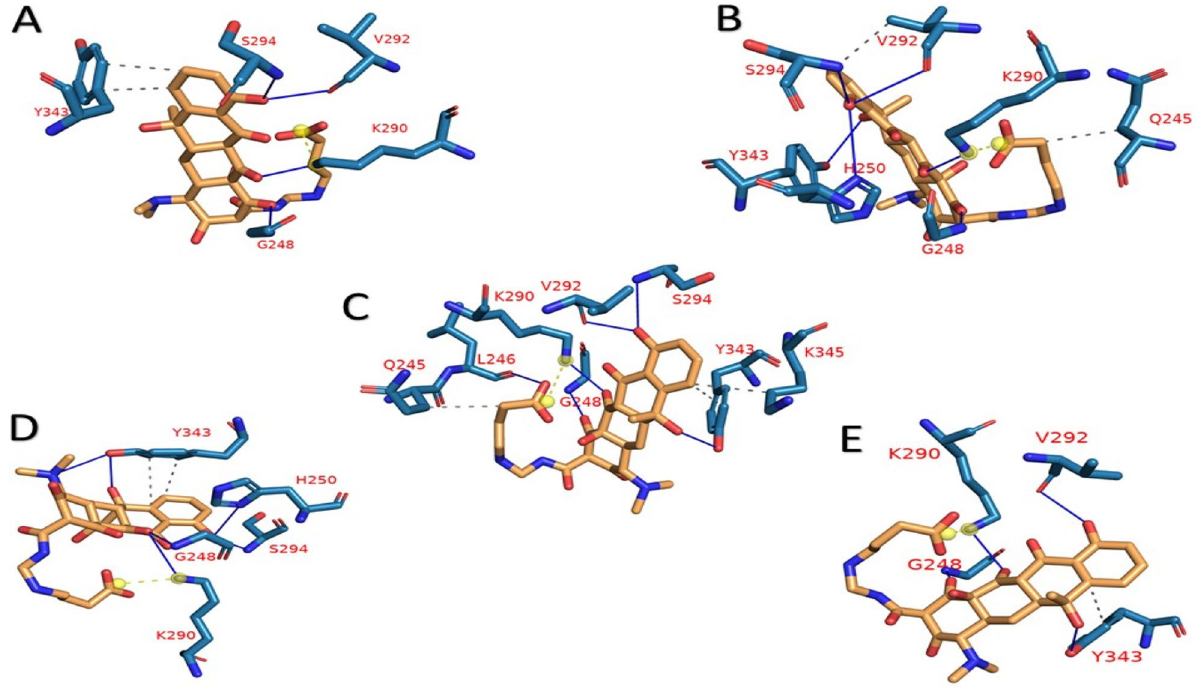
Figure 5. the representative frames ( A – E ) from clustering using TTClust, and the types and number of interactions calculated and depicted using PLIP webserver for NSP15-ZINC000104379474 complex. Dashed- Grey lines: Hydrophobic interactions, blue lines: H-bond, dashed-yellow lines: salt-bridges.